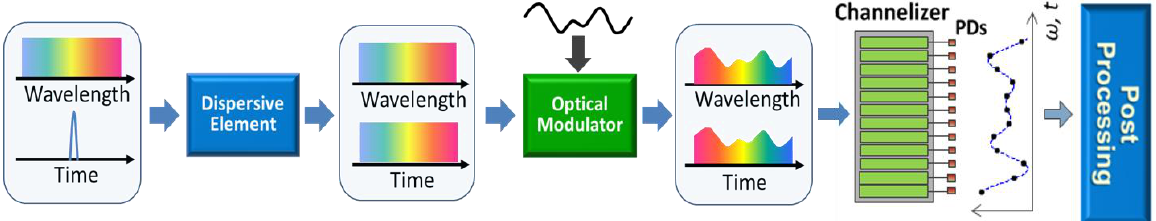
Figure 10. Schematic of real-time microwave spectrum sensing system based on DFT-enabled temporal